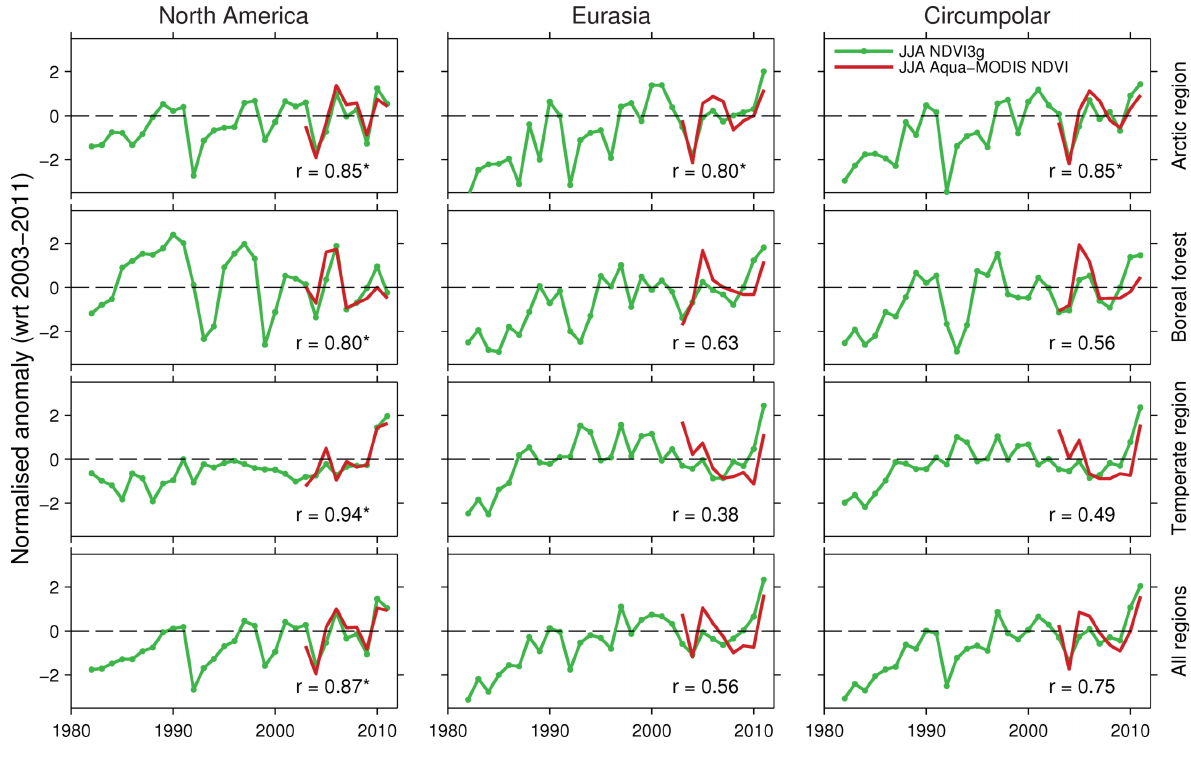
Figure A5. Comparison between summer averages of NDVI3g (green) and Aqua-MODIS NDVI (red) by region and continent during the period